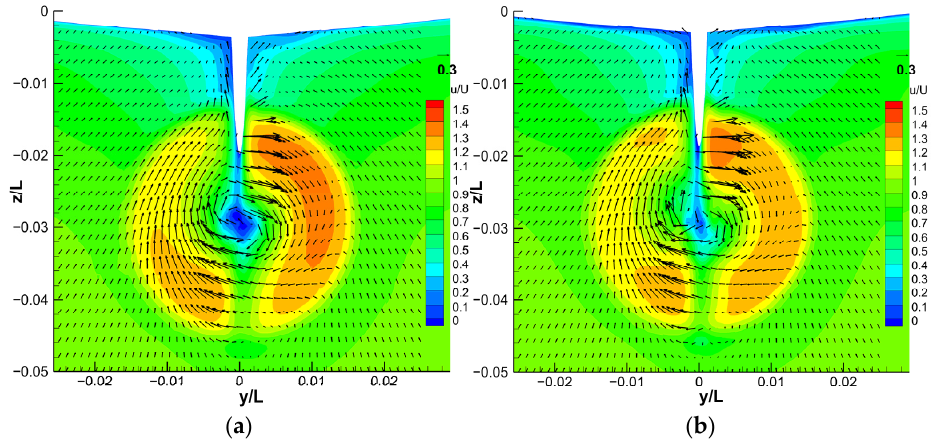
Figure 18. Wake field between propeller and rudder (x/L = 0.99): ( a ) average model; ( b ) rotating blade model.